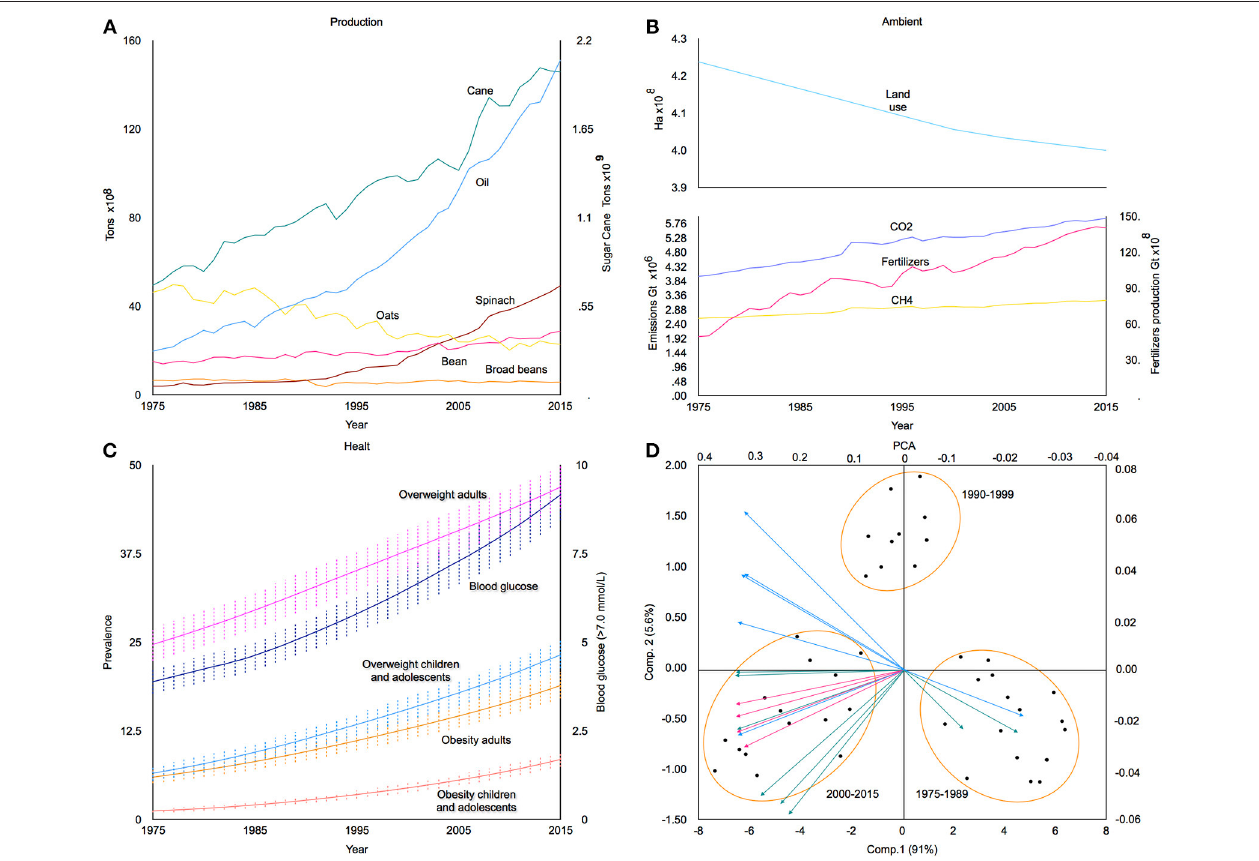
FIGURE 1 | Worldwide health, environmental, and agricultural production data in a 40-year period and the correlation between them. (A) The agricultural production tendency indicates that sugarcane and oil are the main products supplied to the food industry. (B) Environmental data represented by land-use change as natural areas are reduced in size while agricultural land coverage and CO 2 and CH 4 emissions increase. (C) The rise in the prevalence of overweight and obesity in adults and children, and diabetes, measured by the amount of blood glucose. (D) Principal component analysis (PCA) of 15 variables and worldwide demography data. Health variables: (1) Overweight adults, (2) blood glucose, (3) overweight children and adolescents, (4) obesity adults, (5) obesity children and adolescents; Agricultural produce variables: (6) Sugarcane, (7) oats, (8) bean, (9) oil, (10) spinach, (11) broad beans; Environmental variables: (12) land use-change, (13) CO 2 , (14) fertilizers, (15) CH 4 . PCA reveals a strong relation between health problems associated with diet trends and with sugarcane production and the use of fertilizers.